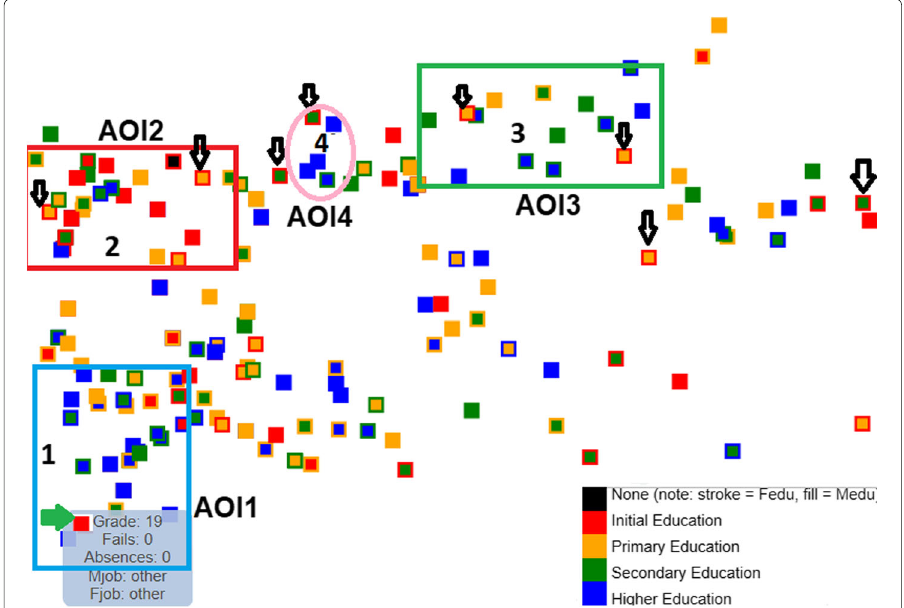
Fig. 19 Isomap for "Mathematics" class, period 1, considering female